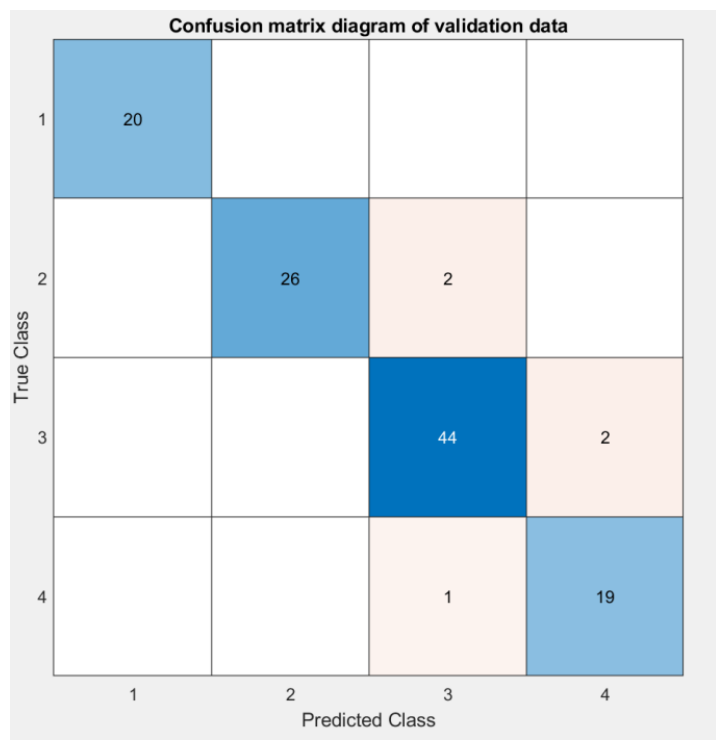
Figure 9. Confusion matrix diagram of validation data.